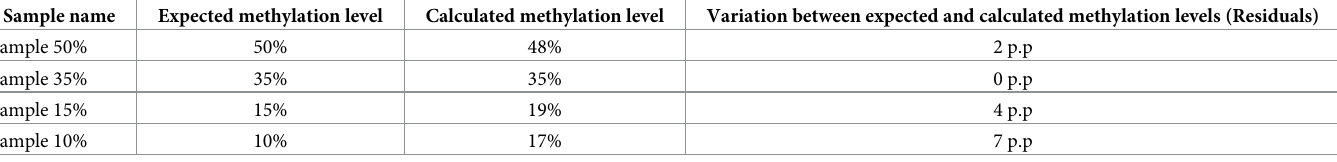
Table 2. Calculation of the methylation levels in the detection window for the EpiMelt MGMT